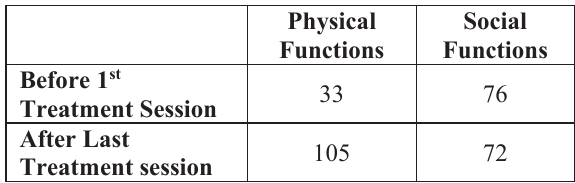
Table-1: Score of Facial Disability Index.